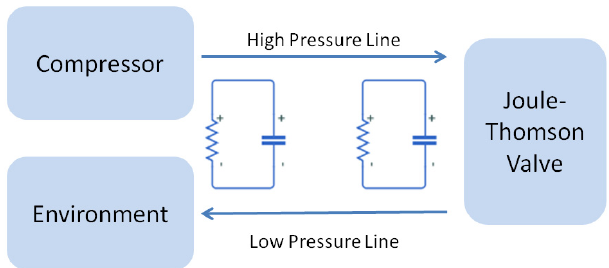
Figure 11. Prototype of the heat exchanger contribution.